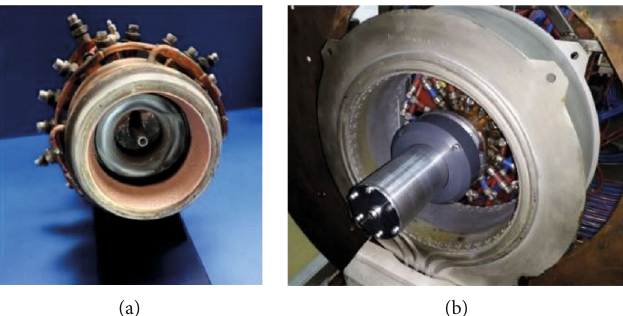
Figure 7: AF-MPD SX3 thruster: (a) SX3 thruster after test campaign without SX coil (BN3); (b) mounted SX3 thruster and SX coil assembly [24].